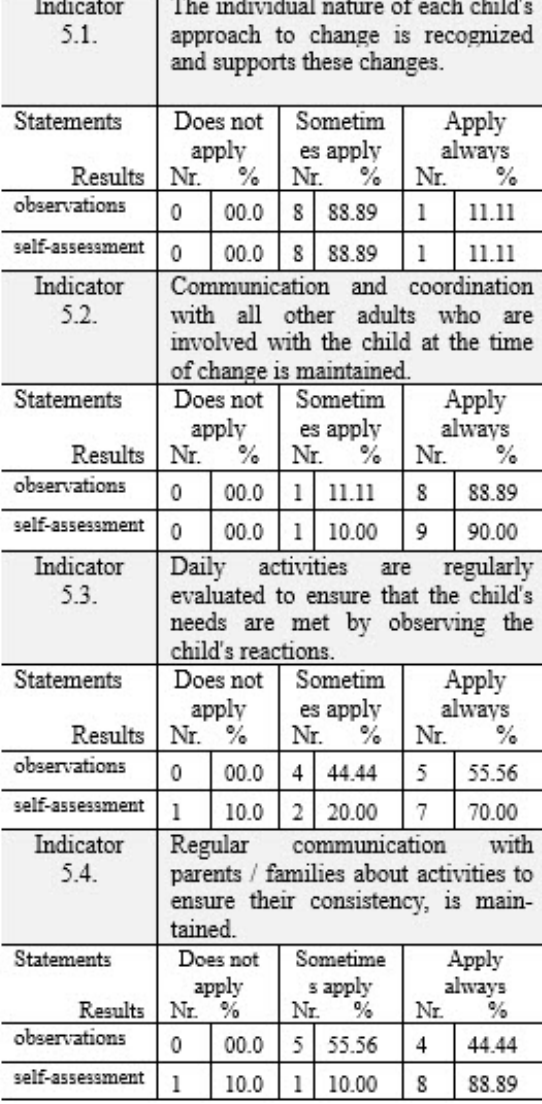
Table 5. Principle 5: Relationships sup - port / facilitate children under the age of three in changing their day-to-day and extraordi - nary